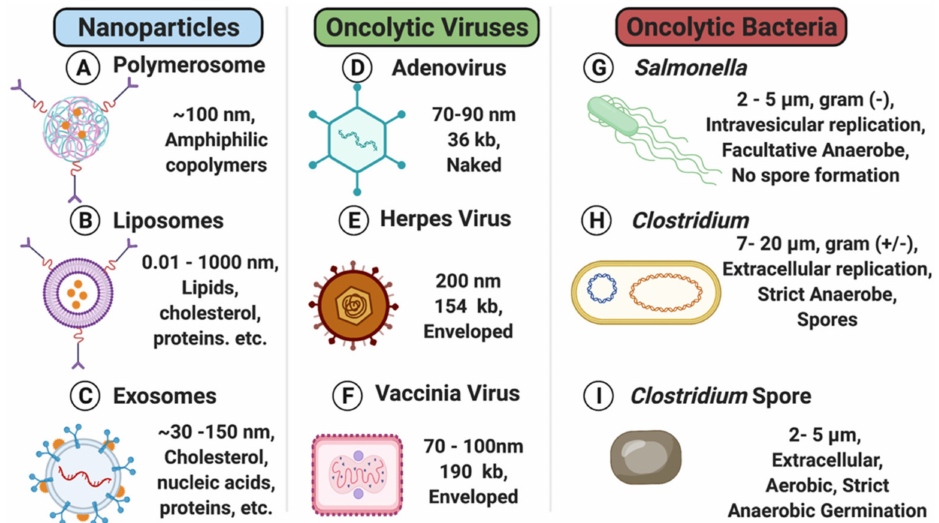
Figure 1. Representative oncotherapeutic modality details, size comparison, and structural char- acteristics. Nanoparticles: ( A ) polymersomes [21], ( B ) liposomes [22], and ( C ) exosomes [23]; on- colytic viruses: ( D ) adenovirus [24], ( E ) herpes virus [25], and ( F ) vaccinia virus [26]; ( G ) oncolytic bacteria: G. Salmonella [27], ( H ) vegetative Clostridium [28], and ( I ) Clostridium spore